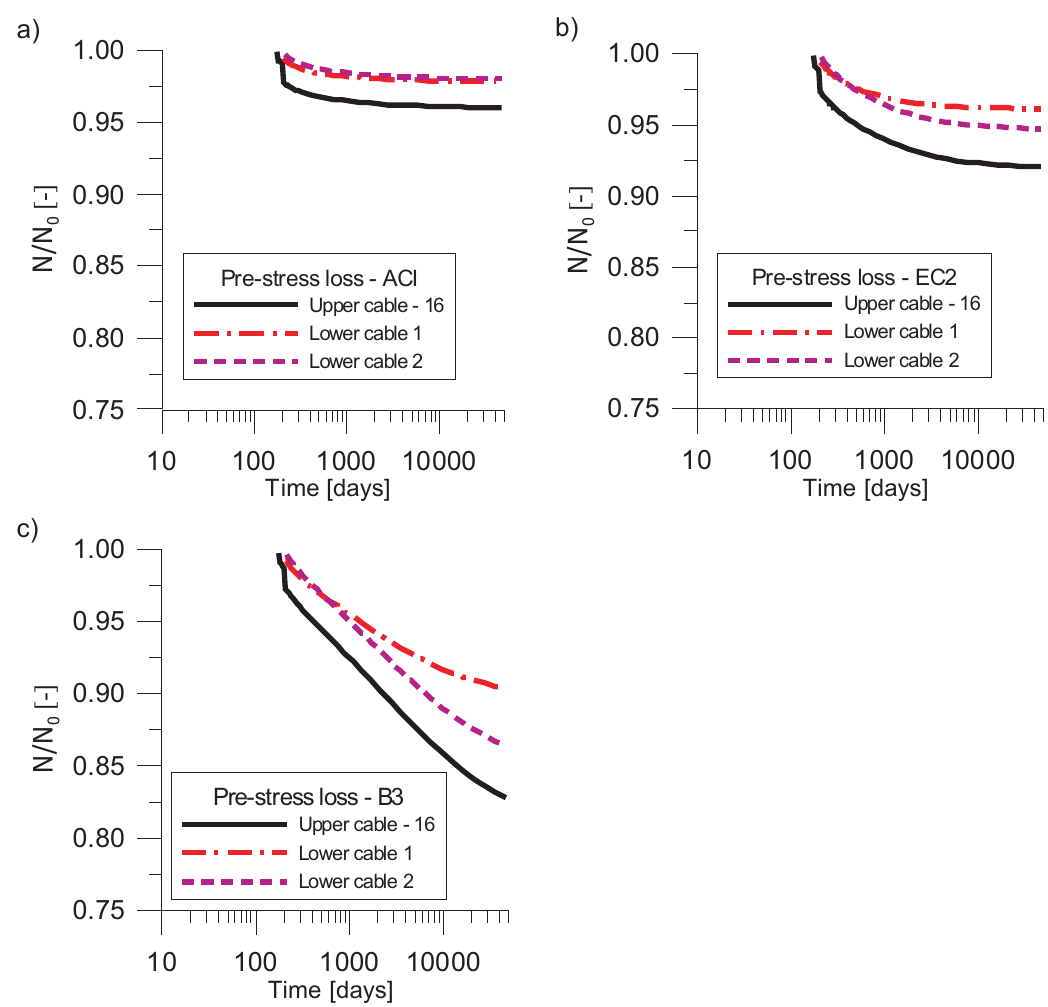
Figure 15. Prestress loss in tendons at main (central) pier by EuroCode2 ( a ), ACI ( b ), and model B3 ( c ) in logarithmic